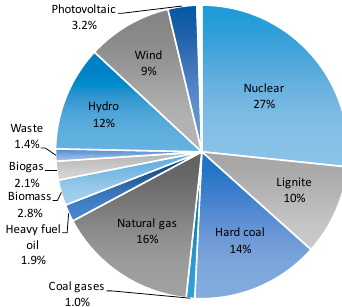
Figure 4. Electricity grid mix used in the LCA (EU-28 mix). Source: Adapted from GaBi Professional Database.